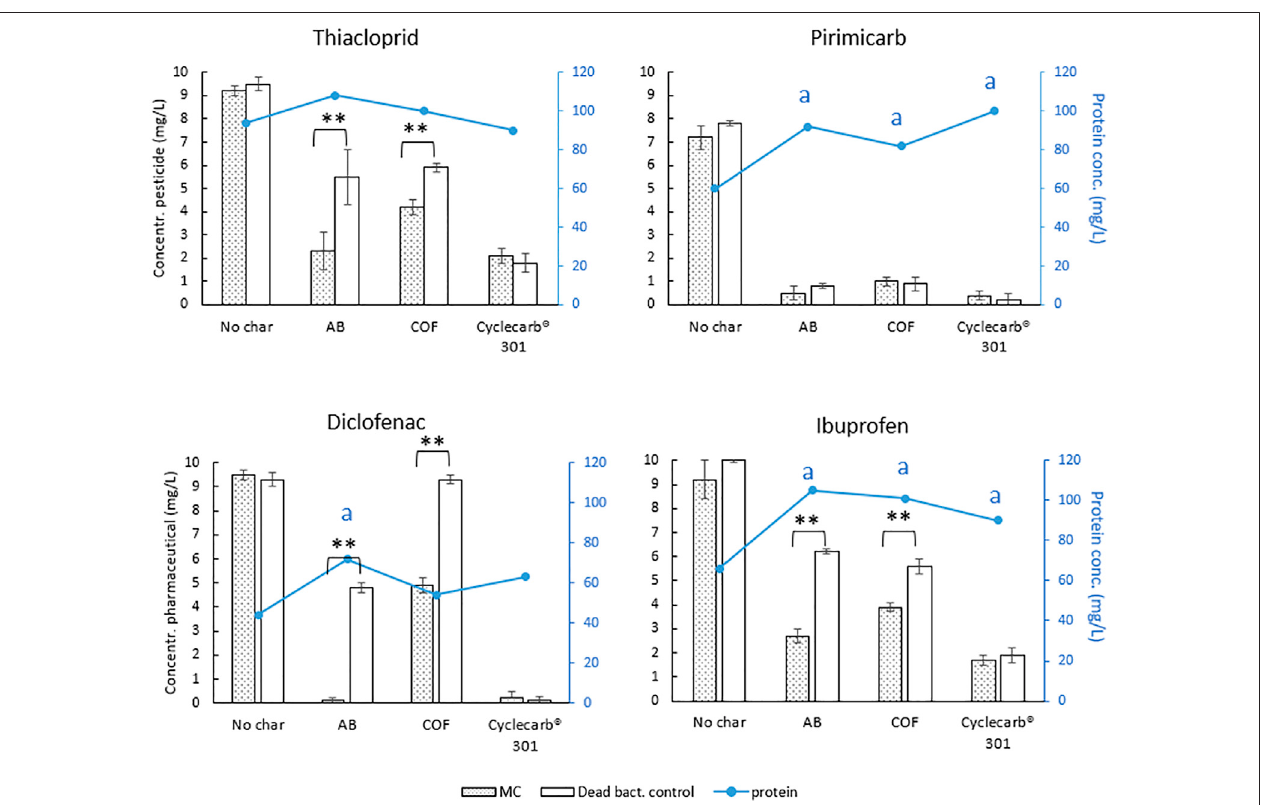
FIGURE7| Pesticideandpharmaceuticalconcentrationsmeasuredinthemediumafter2 weeks.MC=Mixedculture.Shownvaluesaremeansoftriplicates±SD. **Indicates a statistical difference with p ≤ 0.01 (one-way ANOVA, factor Bacteria). Line plot and right axis in blue shows the protein concentrations, letters indicate signi fi cant differences compared to the no biochar control ( p < 0.05, n = 3).